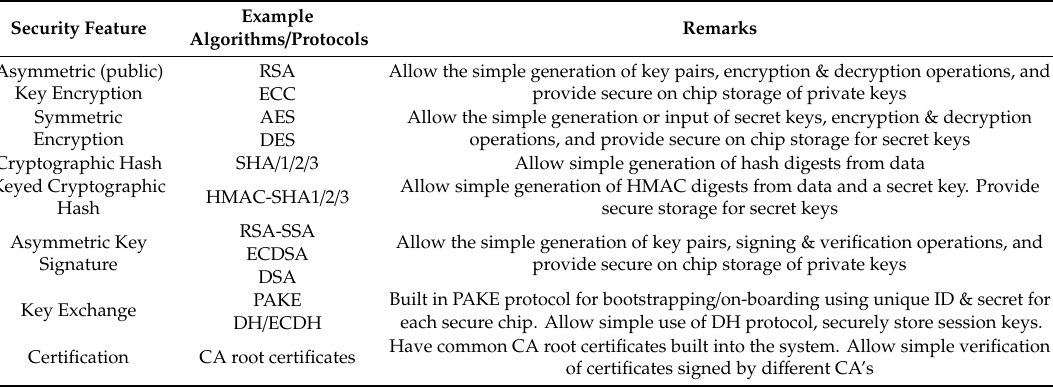
Table 6. General software security